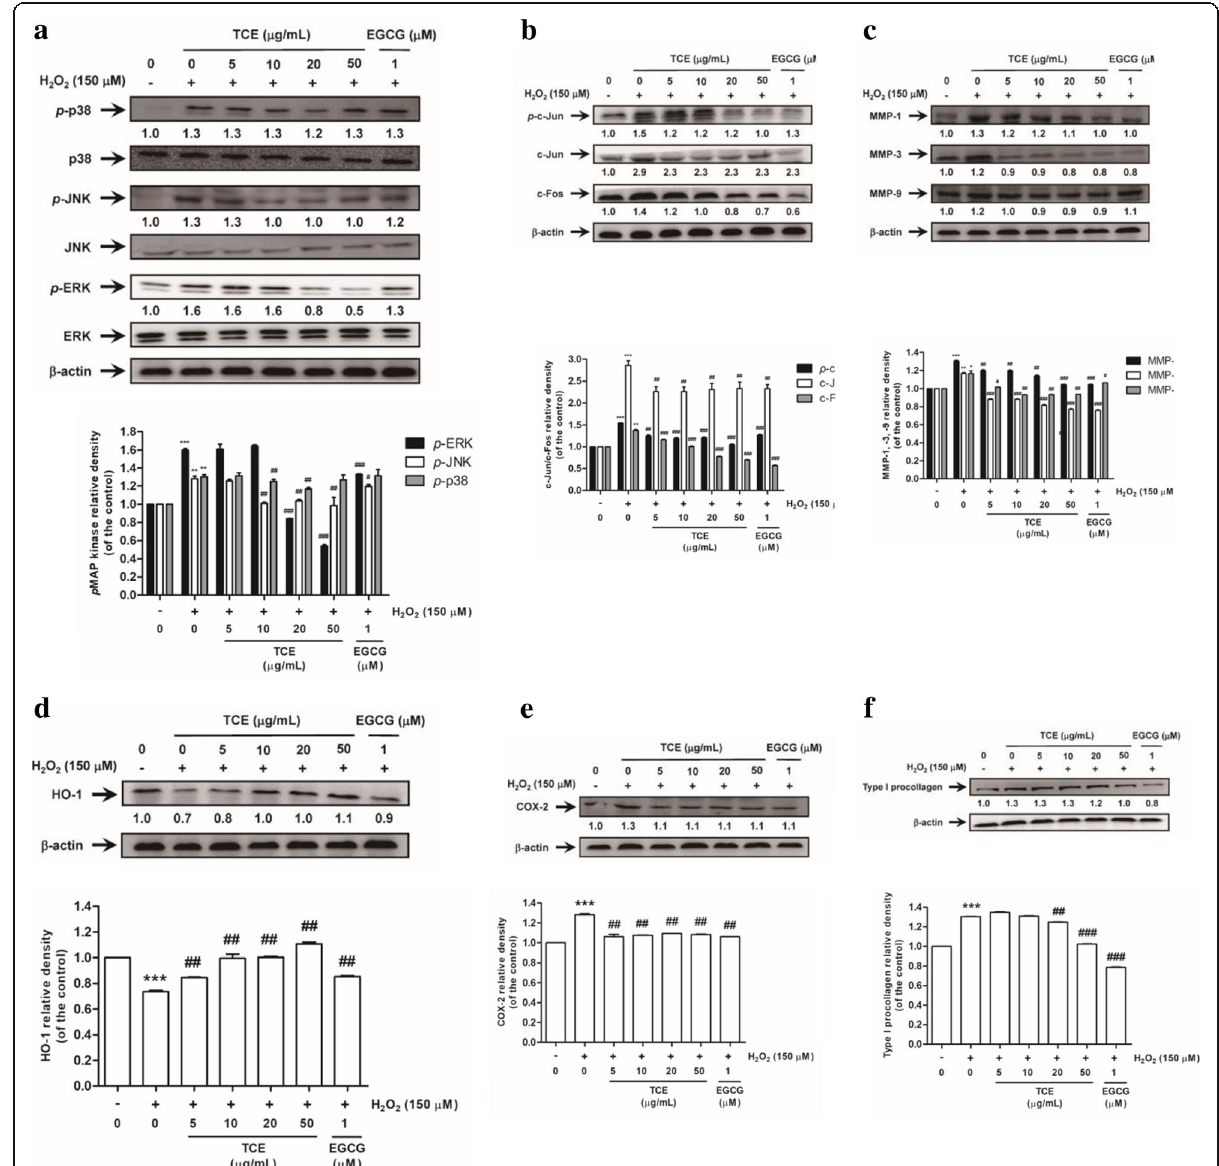
Fig. 3 Effect of TCE on the H 2 O 2 -induced ( a ) phosphorylation of mitogen-activated protein kinases, ( b ) c-Jun phosphorylation and c-Fos, ( c ) matrix metalloproteinase (MMP)-1, − 3, − 9, ( d ) hemeoxygenase-1 (HO-1), ( e ) cyclooxygenase-2 (COX-2) and ( f ) type I procollagen protein expressions in Hs68. Significant difference versus control: * p <0.05; ** p <0.01; *** p <0.001. Significant inhibition versus H 2 O 2 -exposed group: # p <0.05; ## p <0.01; ### p <0.001. EGCG: ( − )-epigallocatechin gallate was used as a positive